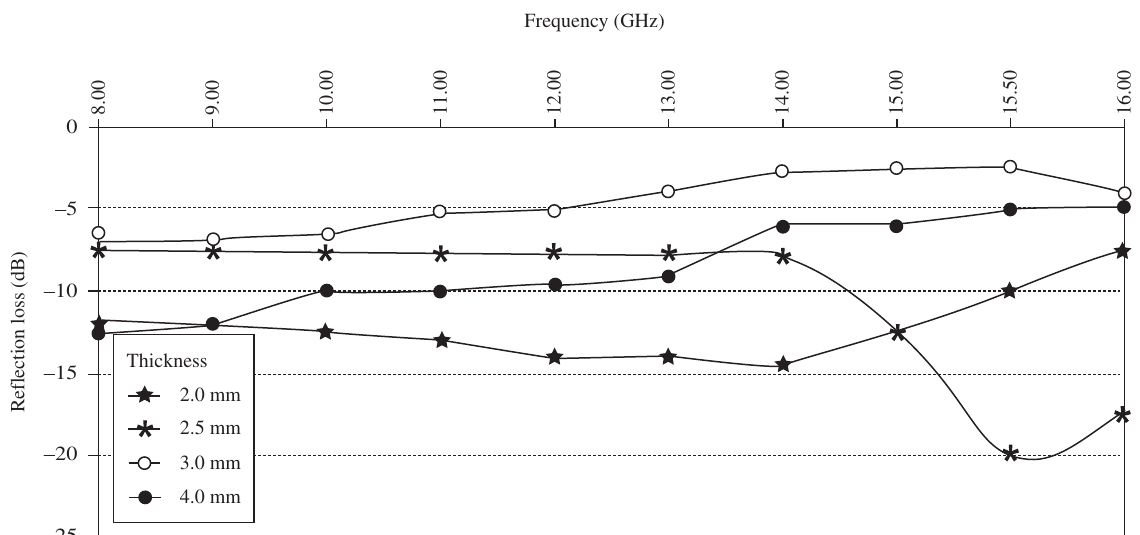
Figure 9. Reflection loss (dB) as a function of frequency (GHz) in X/Ku-bands (8.0-16.0